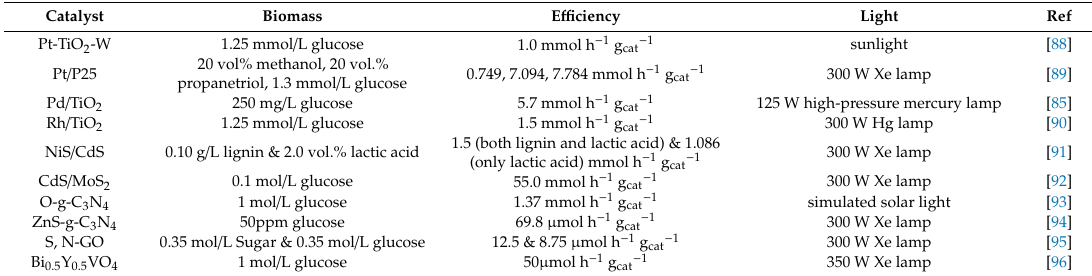
Table 1. Summary of photocatalytic reforming of biomass for hydrogen